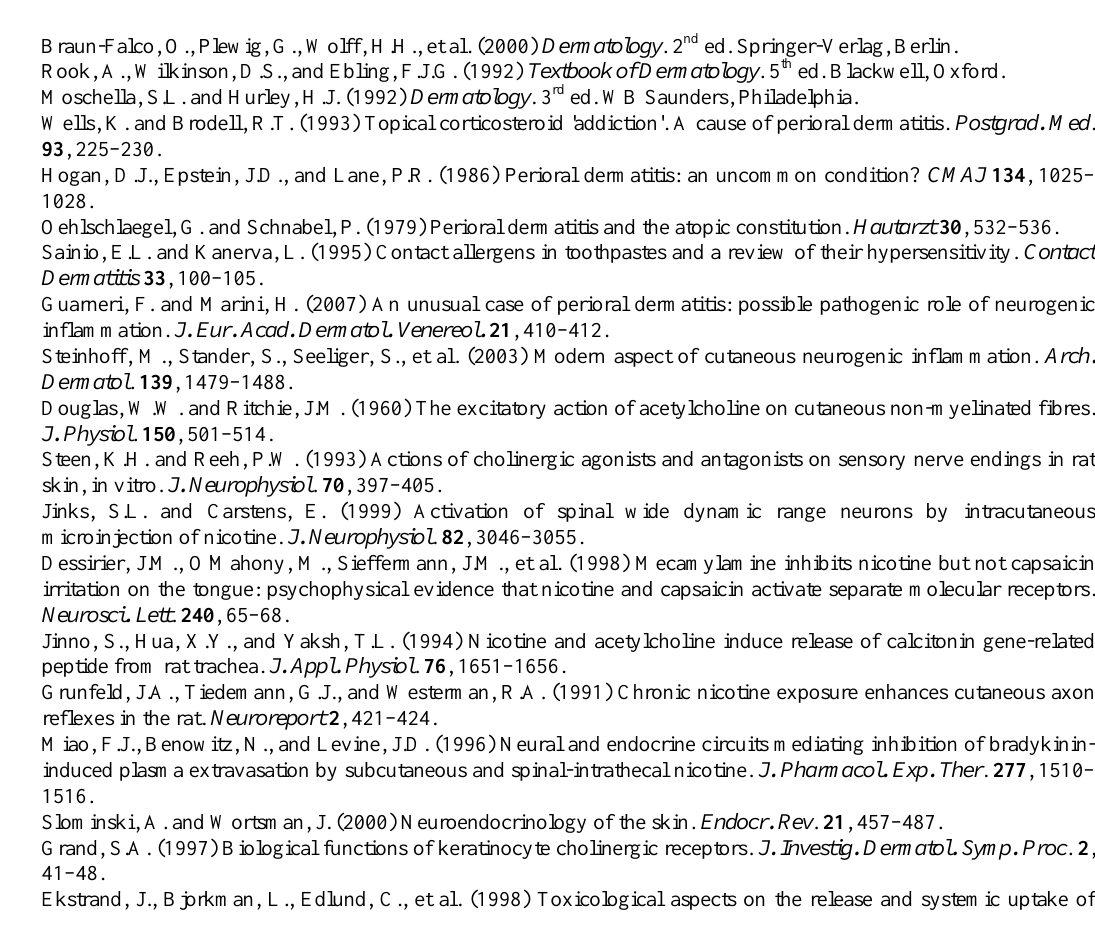
FIGURE 4. Amino acid sequence homology between the tenth transmembrane segment of the vesicular acetylcholine transporter of T. californica and its human counterpart. The symbol “+” indicates a conservative residue substitution. Cysteine-376 of the T. californica protein, identified as a binding point for organomercurials (see ref. 27) is marked in